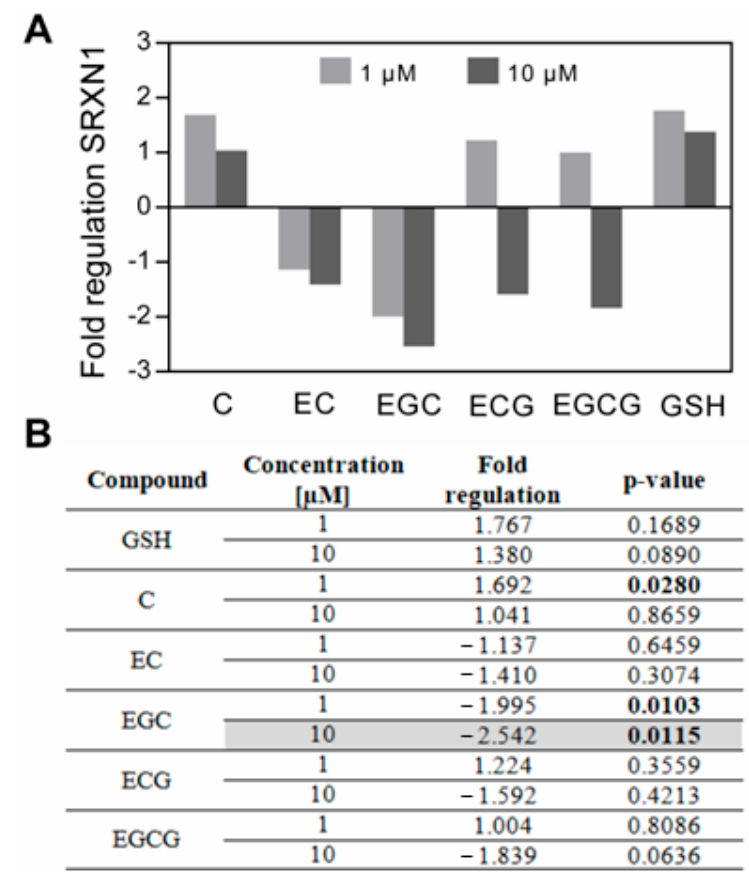
Figure 1. Catechins a ff ect SRXN1 transcription. ( A ) Changes in the expression of the SRXN1 gene induced by 24 h treatment of the HT29 cell line with catechins or glutathione seemed to be structure dependent. ( B ) Statistical signi fi cance of the data presented in Figure 1A. Statistically signi fi cant and biologically relevant changes in SRXN1 expression have been bolded and highlighted, respectively. The results are means of three biological replicates. Abbreviations: C, (+)-catechin;